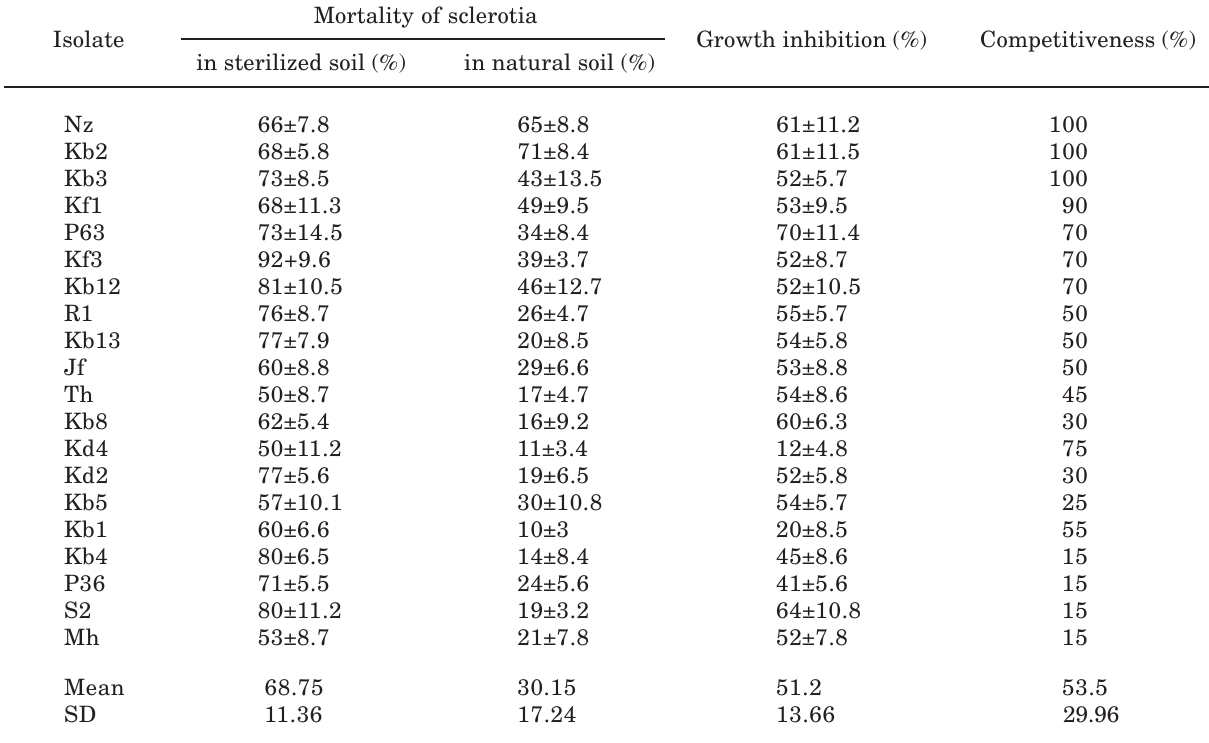
Table 3. Antagonistic action of T. harzianum isolates on sclerotia of S. rolfsii in natural soil and in sterilized soil, their effect on mycelial growth of S. rolfsii after 72 hours of incubation at 30°C and their saprophytic competitive ability on PDA in Petri